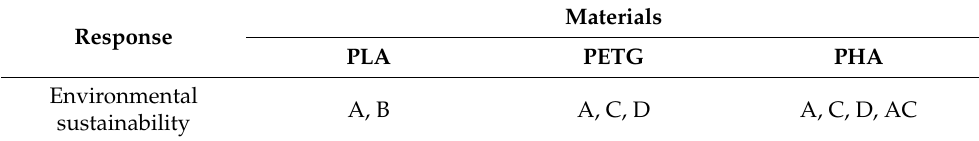
Table 5. The most important factors and interactions for environmental sustainability.